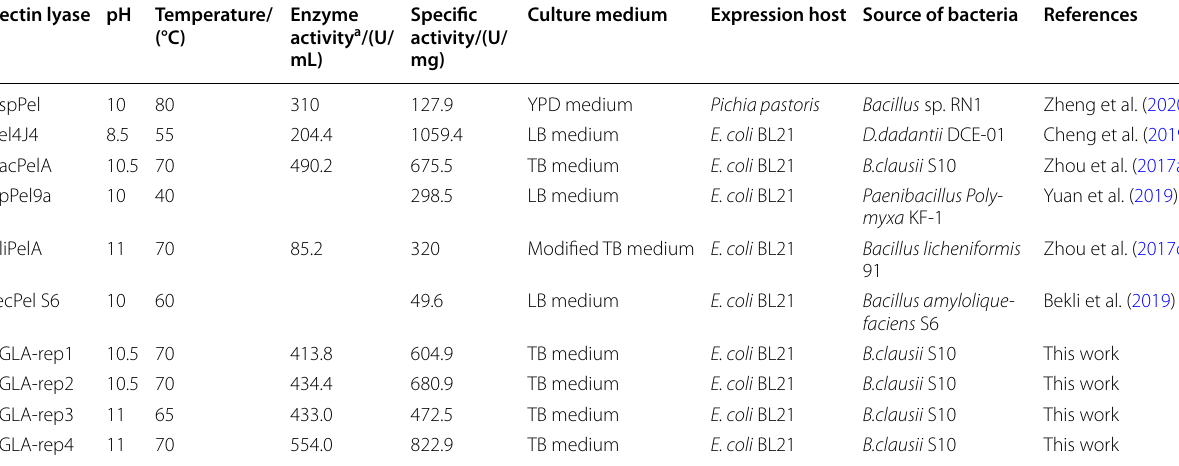
a The activity was determined by the A235 method, and the average value of three experiments was expressed